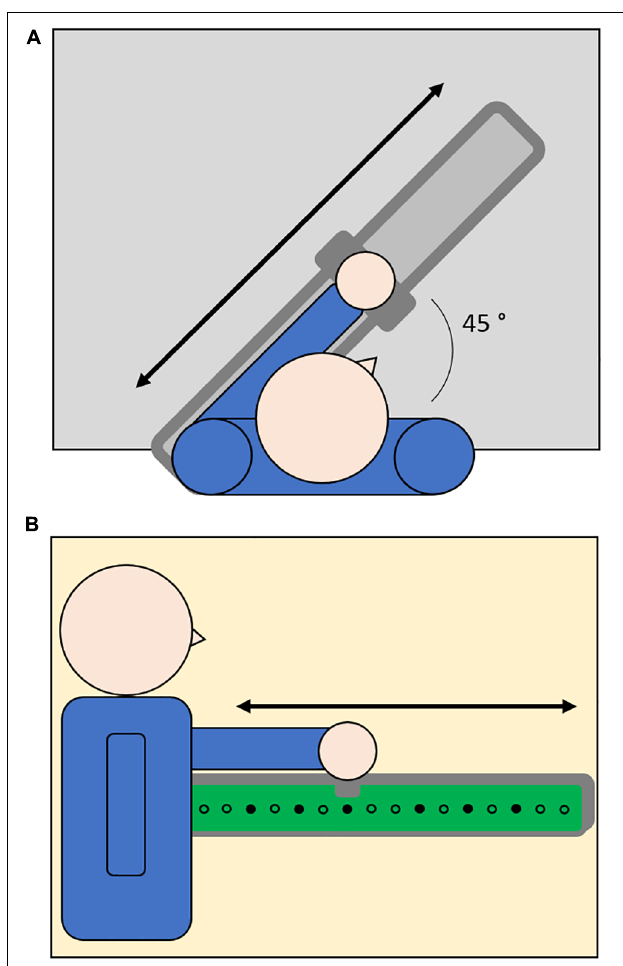
FIGURE 1 | Top-view (A) and side-view (B) of setup configuration. Participants were seated at a table and their dominant or non-dominant arm was positioned on a metallic rail (light gray, 1A) placed above an array of audio speakers (dots, 1B) mounted on a tactile surface that can register the position of the contact (green surface, 1B). To perform the task, participants were asked to hold a handle to slide over the metallic rail and indicate the position of auditory (Reaching of Auditory Cue Task) or proprioceptive (Joint Position Matching Task) targets (filled